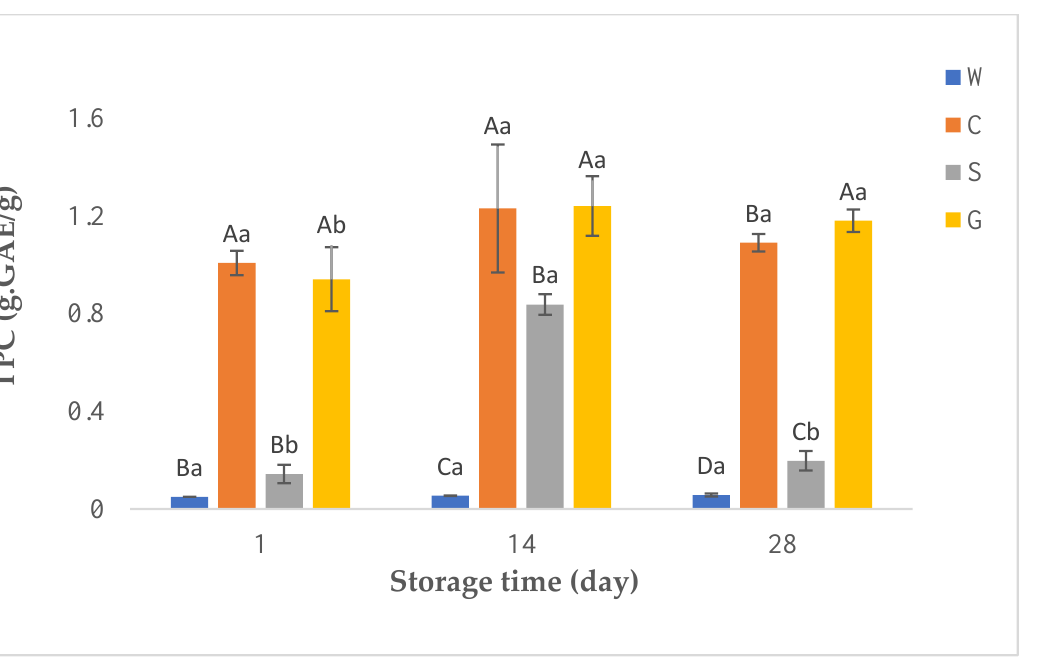
Figure 2. TPC (g.GAE/g) in probiotic fermented whey beverages enriched with kiwi powder. a,b Means ± standard deviations in the same beverage group with different superscript lowercase letters are significantly different ( p < 0.05); A–D Means ± standard deviations in the same storage day with different superscript uppercase letters are significantly different ( p < 0.05). C = probiotic fermented beverage produced from cow WPC and enriched with kiwi powder, G = probiotic fer- mented beverage produced from goat WPC and enriched with kiwi powder, S = probiotic fermented beverage produced from sheep WPC and enriched with kiwi powder, W = probiotic fermented beverage produced without WPC and enriched with kiwi powder.